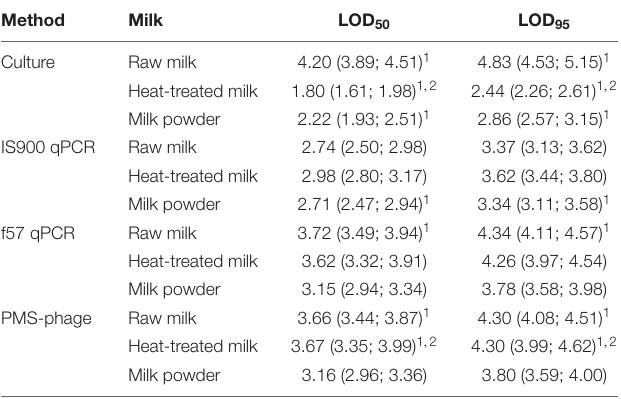
TABLE 4 | Mycobacterium avium subsp. paratuberculosis inoculation levels L 0 , L 1 , L 2 , and L 3 , calculated from pure culture enumerations, in milk test portions prepared for the LOD study expressed in Log 10 cells per 50 ml of milk.